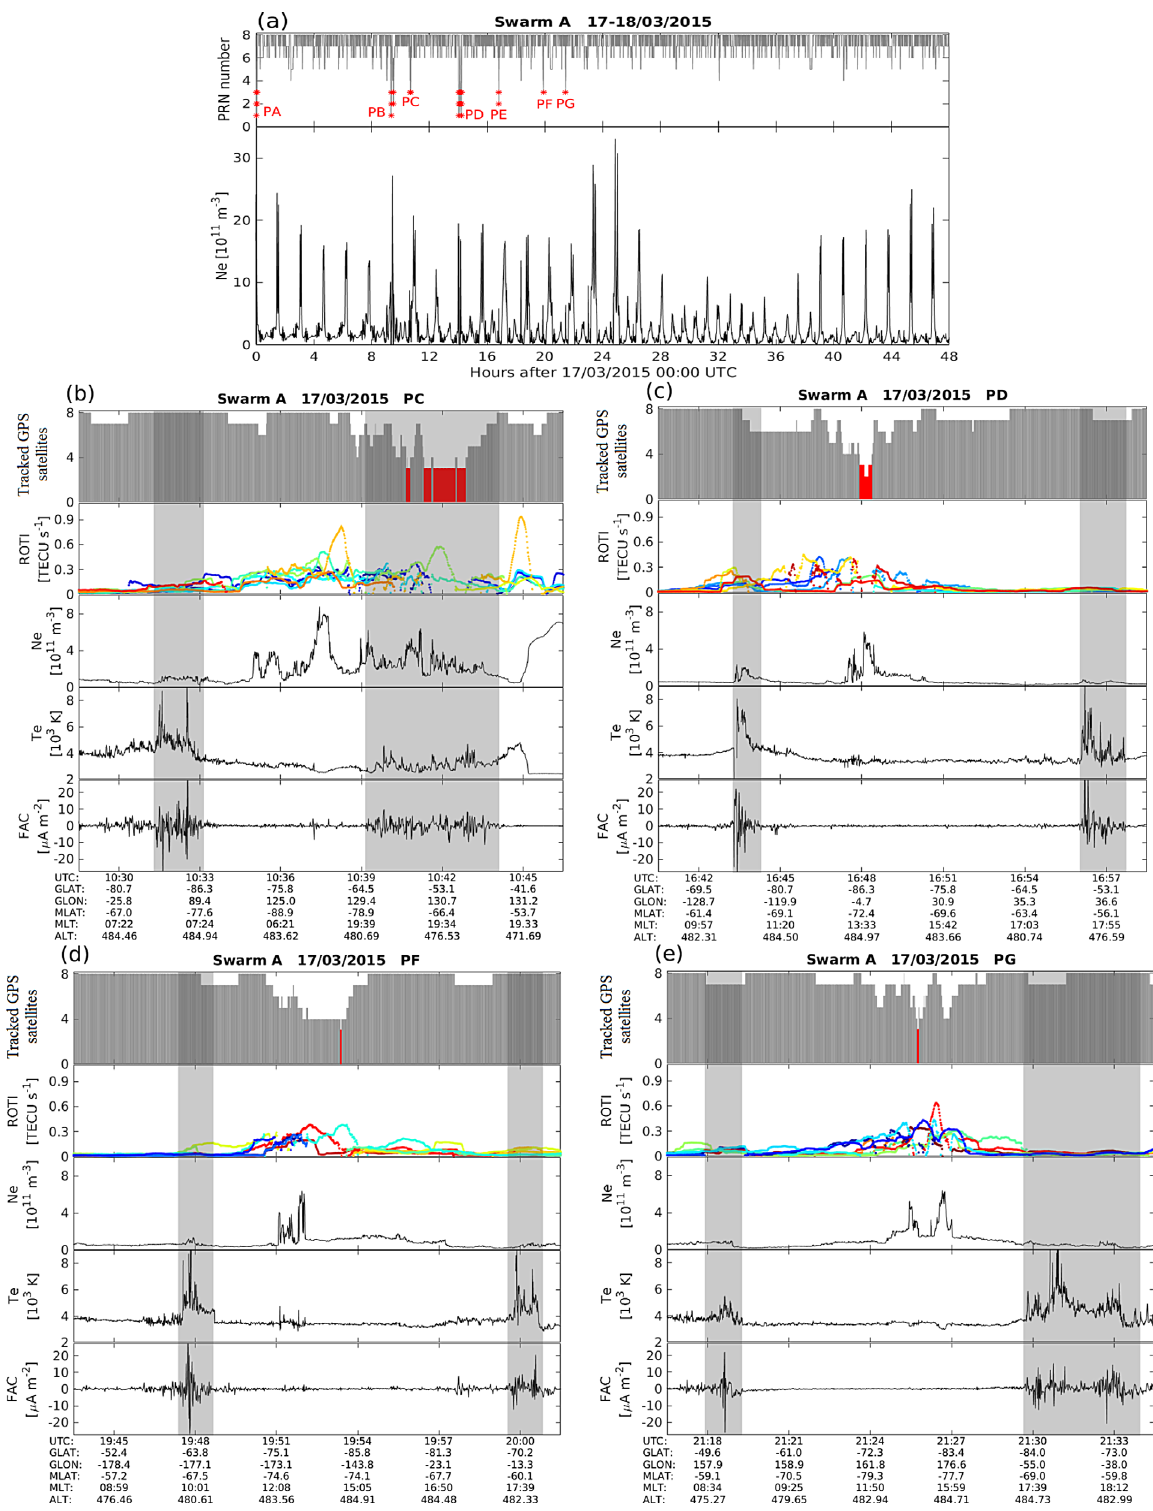
Fig. 5. (a) Swarm A (top) tracked GPS satellite number and (bottom) in situ electron density measurements along its orbits on 17 – 18 March 2015. There are seven periods when Swarm A tracked GPS satellite number less than four, and they are indicated by red asterisks and marked as periods PA to PG. The detailed variations of tracked GPS satellite number, ROTI, in situ electron density and temperature, as well as the small-scale FAC pro fi les of Swarm A for four periods at high latitudes when tracked GPS satellite less four (indicated by red color in the top frame) are